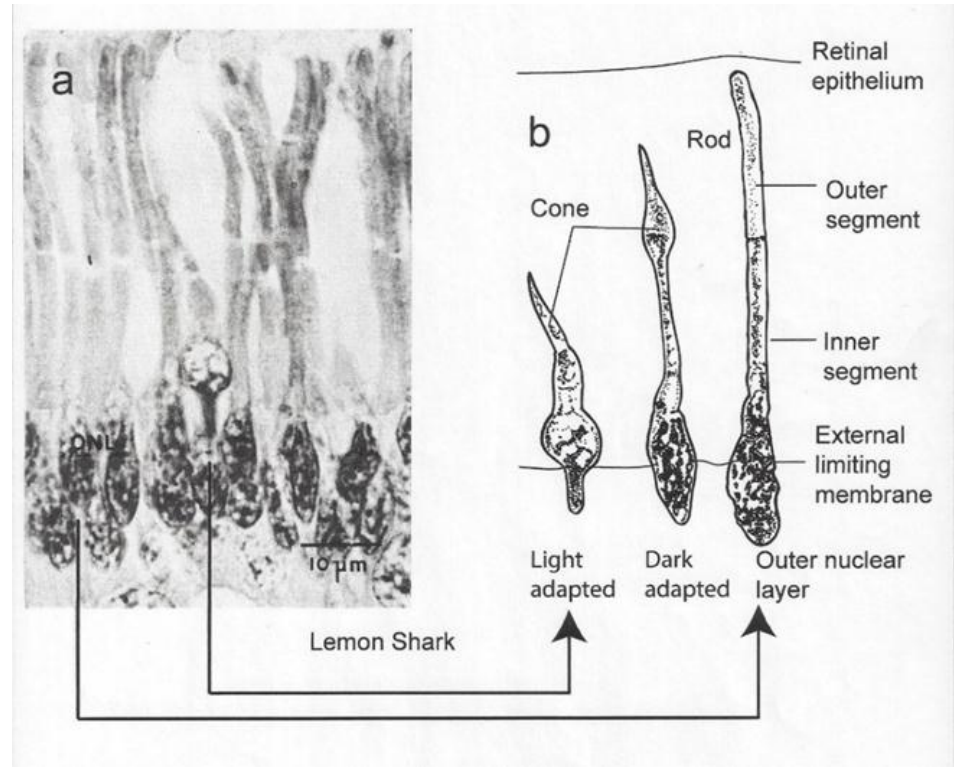
Figure 1. ( a ) Micrograph showing single cone surrounded by rods; ( b ) diagram of dark- and light- adapted cone and dark-adapted rod [5]. The two receptors have different functions [5,6]. The rods are highly sensitive to quanta of irradiance, and enable the shark to distinguish objects under the low levels of irradiance present during dawn, dusk, and nighttime conditions. They also permit the sharks to see well in the blue-shifted spectrum present in oceanic waters (Figure 2b). The cones are less sensitive to quanta of light and permit the shark to distinguish an object during daytime from its background by its slightly different brightness. They also permit the sharks to see well in the red-shifted coastal waters (Figure 2c). Situated within the outer segments of these receptors are two irradiance-sensitive pigments, rhodopsins and porphyropsins [7]. The rhodopsins, which are present in the rods, are most sensitive to blue-green irradiance varying between 497 and 510 nm that are present in the open ocean (as well as during dawn, dusk, and nighttime in coastal waters) [7]; the porphyropsins, which are present in the cones, are red-shifted [8]. They possess a higher peak absorption at a wavelength of 522 nm, and thus are better suited to absorbing irradiance in the spectral conditions of coastal waters during